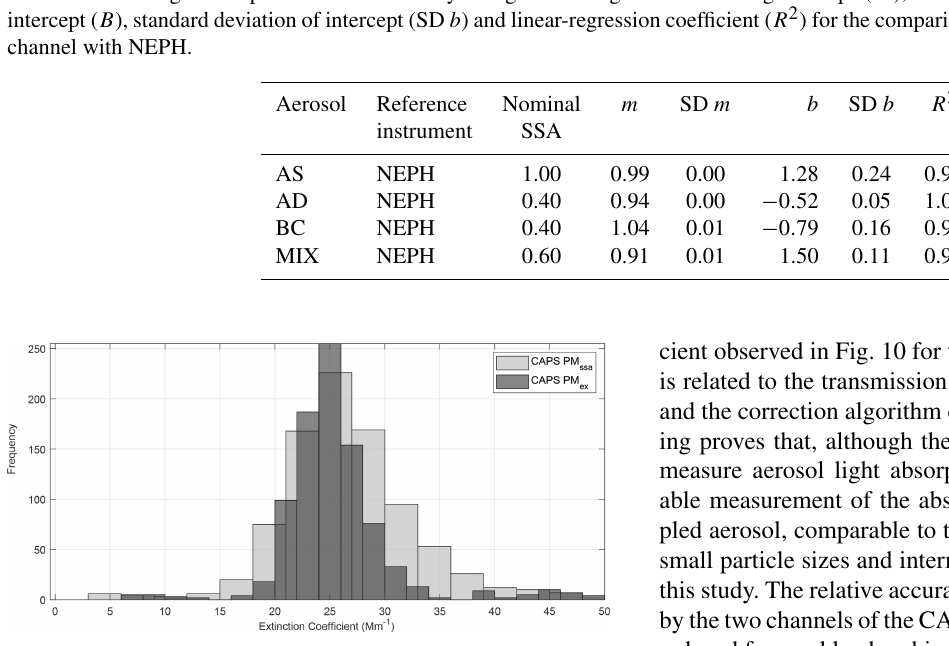
Figure 7. Frequency of extinction coefficient measurement for the CAPS PM SSA and PM ex systems at the nominal 25Mm − 1 (level 5) test point for